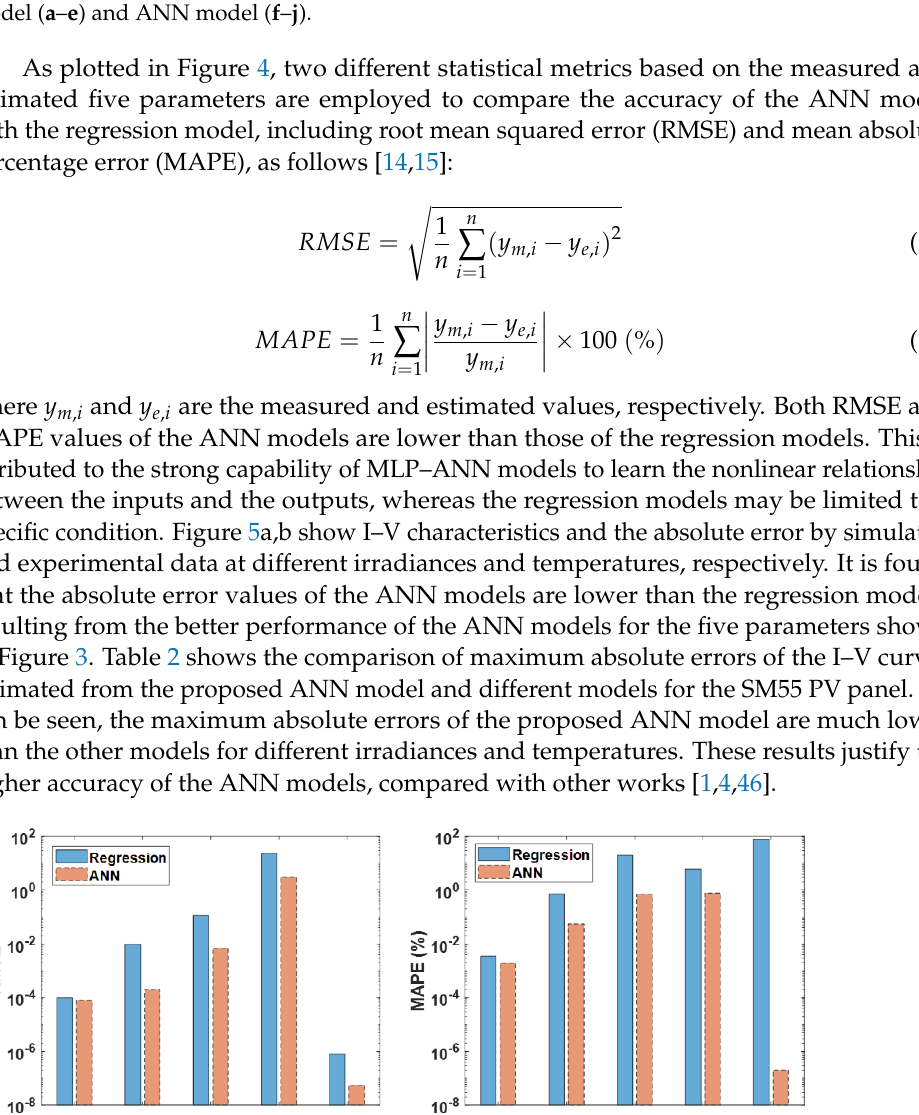
Figure 3. Dependence of the five parameters on temperature and solar irradiance for the regression model ( a – e ) and ANN model ( f – j ).